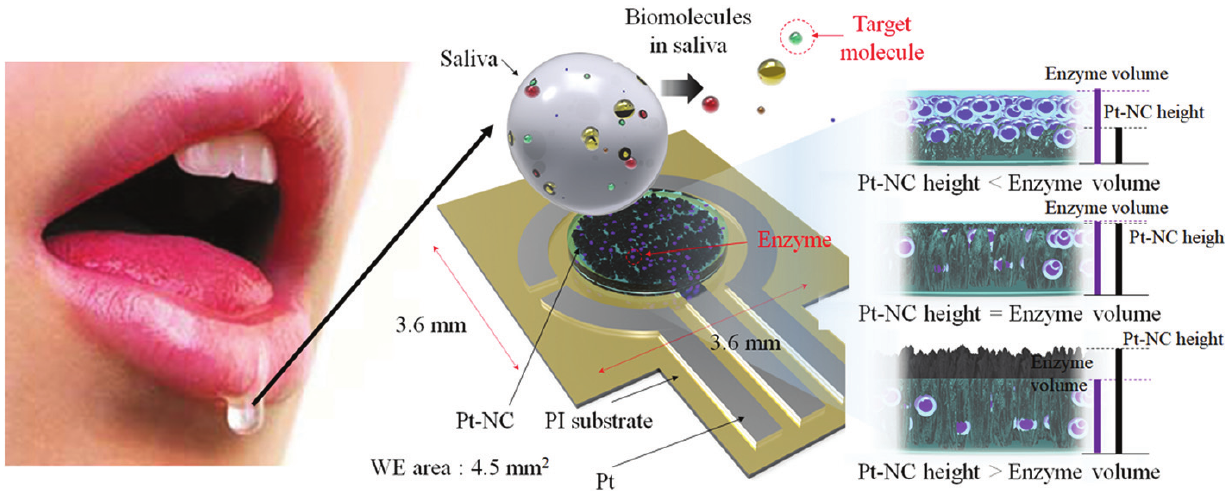
Figure 3. Biosensor with a Pt nano-cluster and strategy on changing the concentration of enzyme over the surface area of Fig. 1 A schematic for an electrochemical biosensor with a Pt nano-cluster and the strategic approach for improving sensor ’ s performance by opti- the substrate may improve sensor’s performance by optimizing the effective surface area and enzyme volume mizing between the e ff ective surface area and enzyme volume.